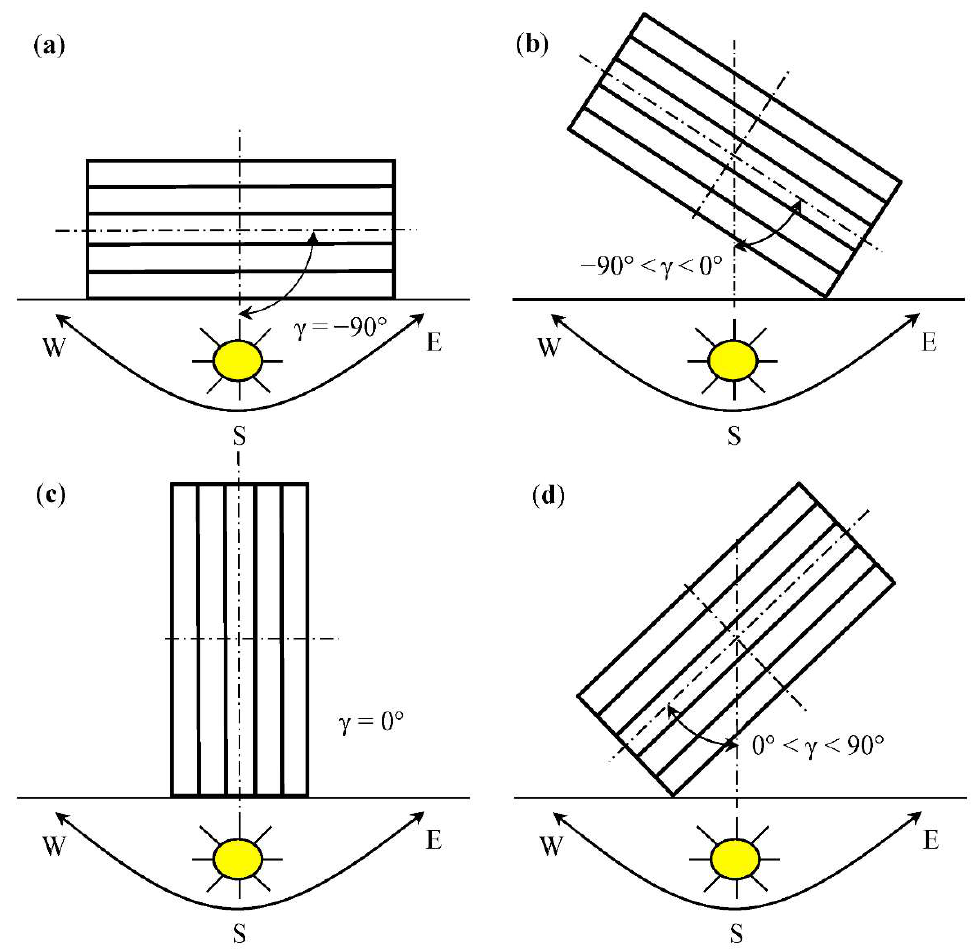
Figure 2. Position of enclosure in south direction—effect of enclosure’s azimuth γ : ( a ) γ = − 90 ◦ —the channel axes are perpendicular to south direction; ( b ) − 90 ◦ < γ < 0 ◦ —the channel axes are located between east and south directions; ( c ) γ = 0 ◦ —the channel axes are parallel to south direction; ( d ) 0 ◦ < γ < 90 ◦ —the channel axes are located between the south and west directions.